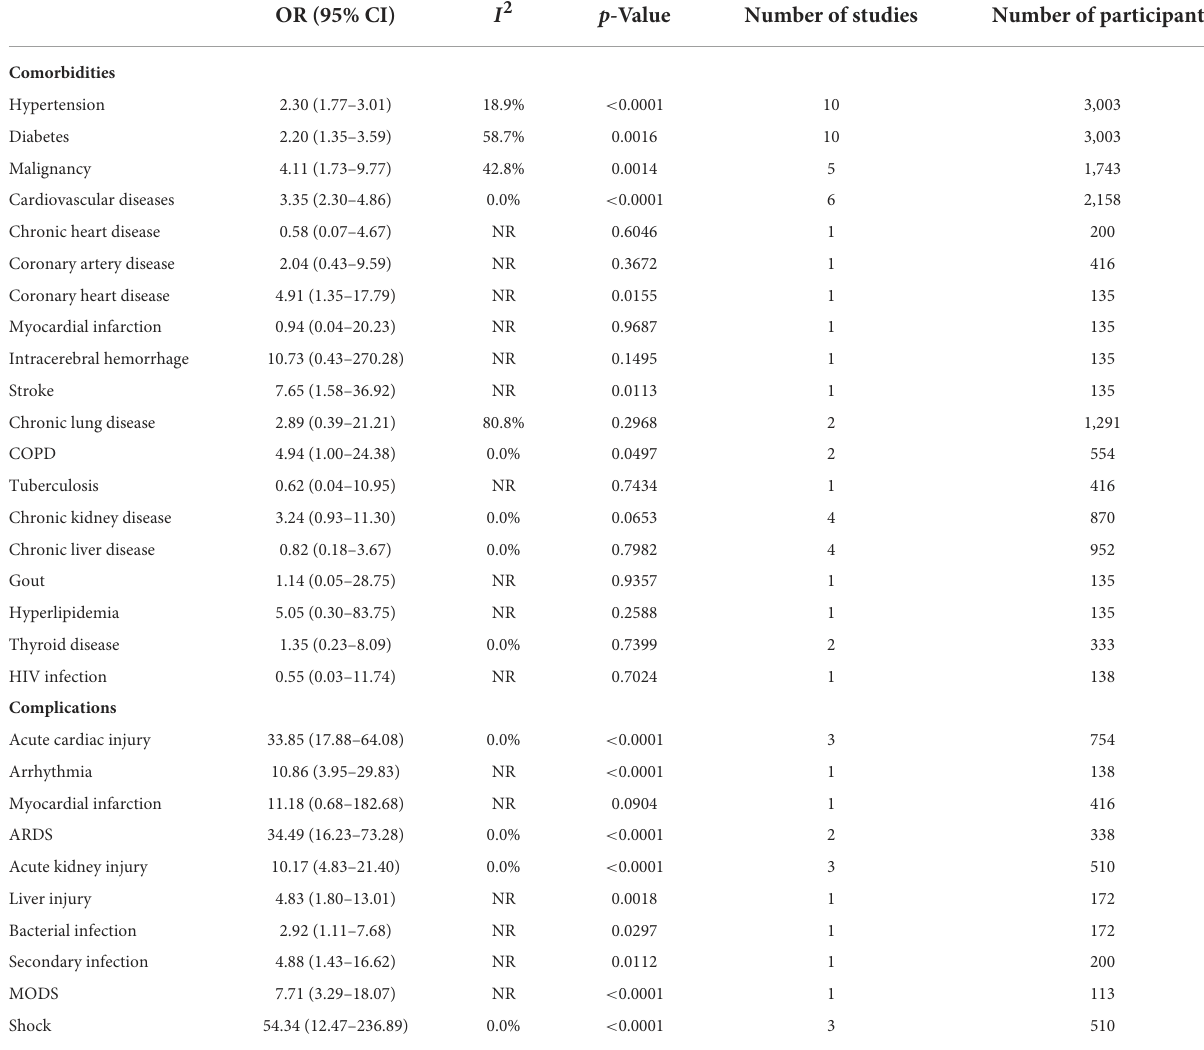
TABLE 2 Meta-analysis summary of comorbidities and complications for COVID-19 by ICU admission vs. non-ICU admission. OR (95% CI) I 2 p -Value Number of studies Number of